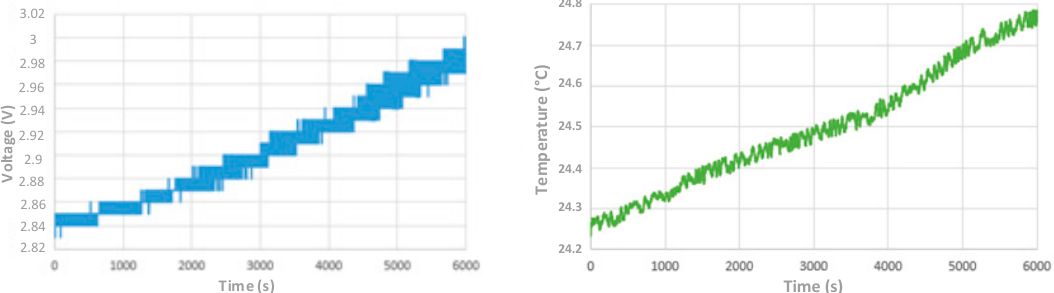
Figure 10. Time waveform of battery voltage ( left ) and its surface temperature ( right ) during the first regeneration sequence.